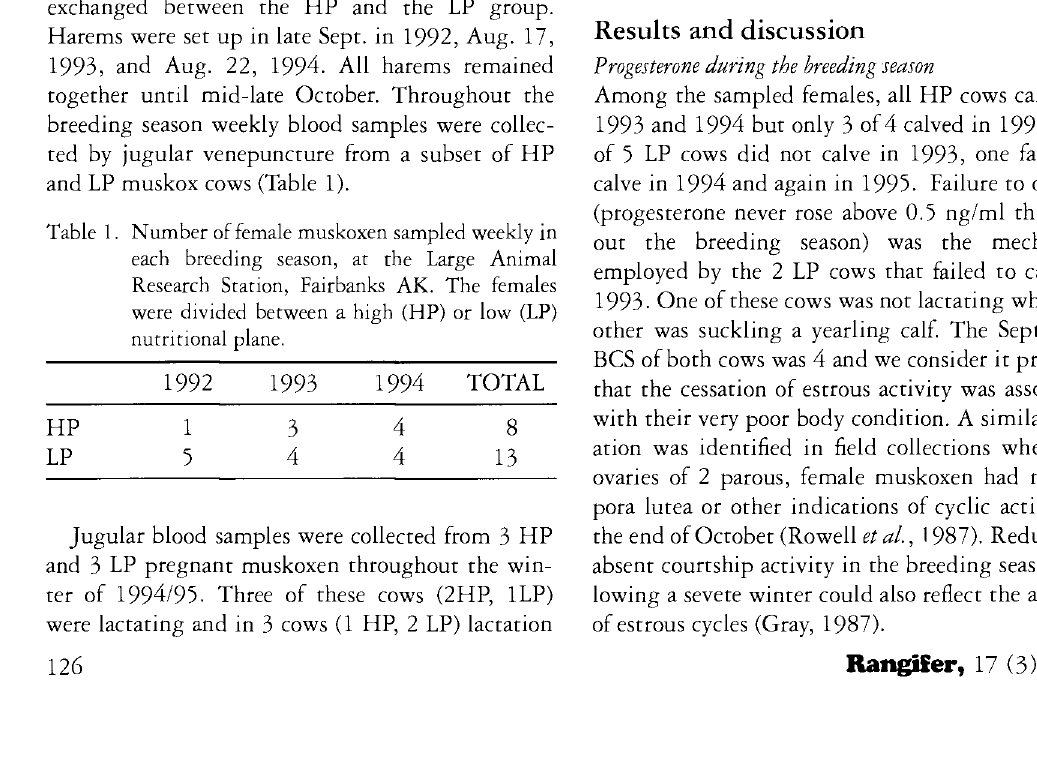
Table 1. Number of female muskoxen sampled weekly in each breeding season, at the Large Animal Research Station, Fairbanks AK. The females were divided between a high (HP) or low (LP) nutritional